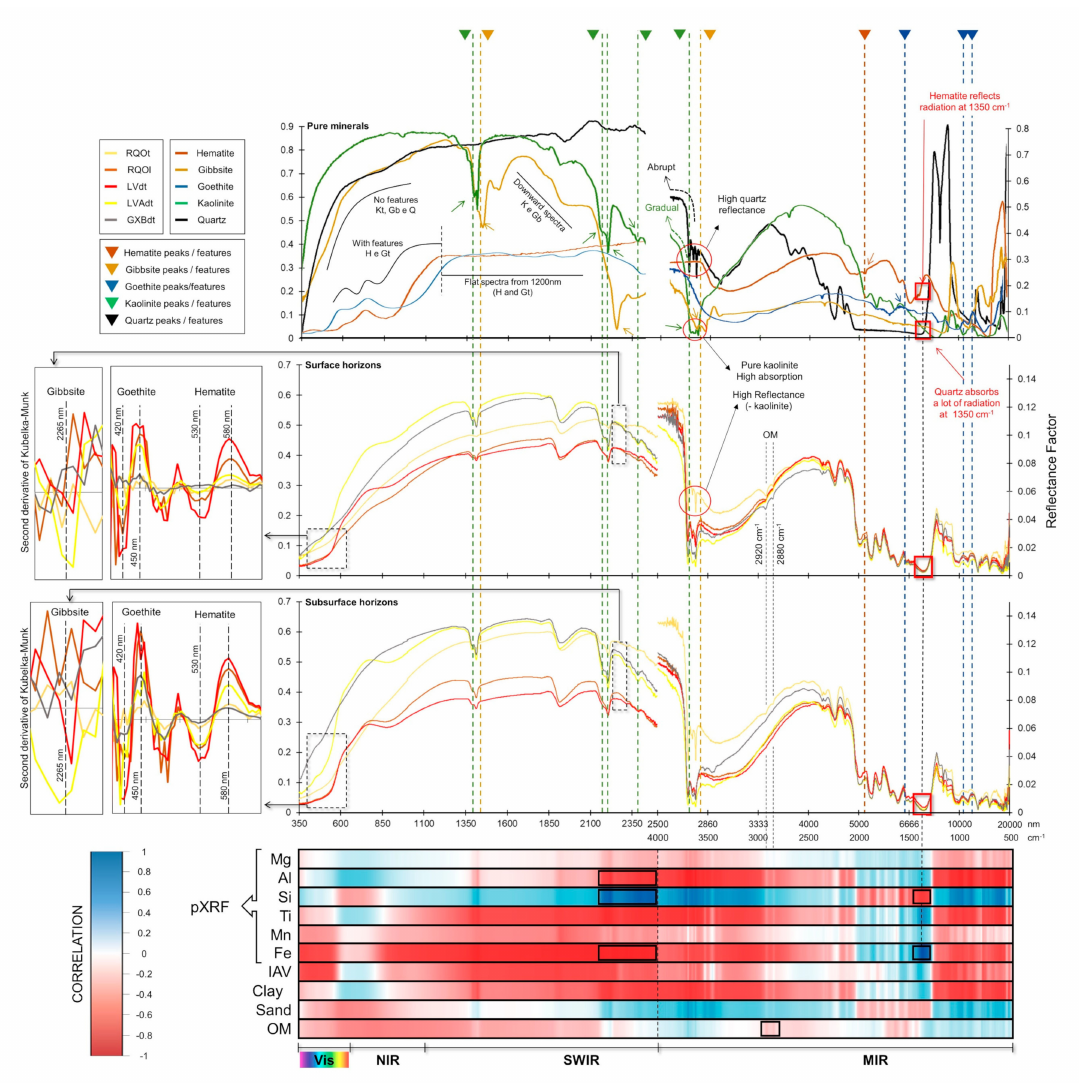
Figure 4. VNS and MIR spectra of different soil classes according to SiBCS, their relation with pure mineral spectra and correlation with physical attributes, and total element content